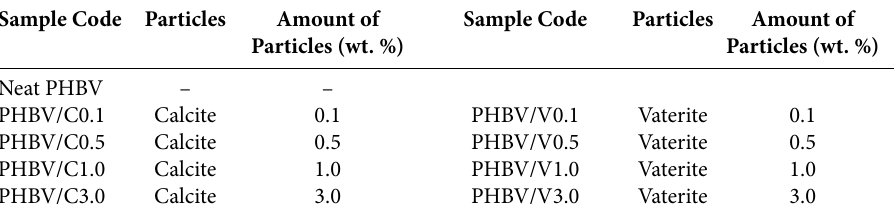
Table 1. Experimental conditions for obtaining the composites Sample Code